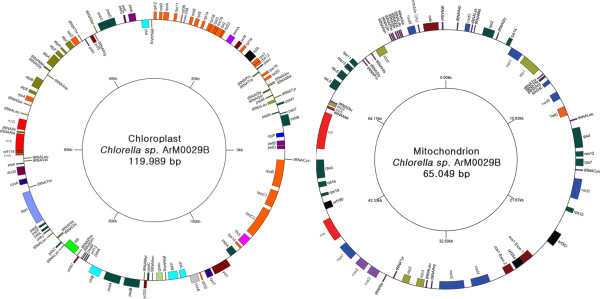
Plastid and mt genomic maps of
Chlorella sp
. ArM0029B.